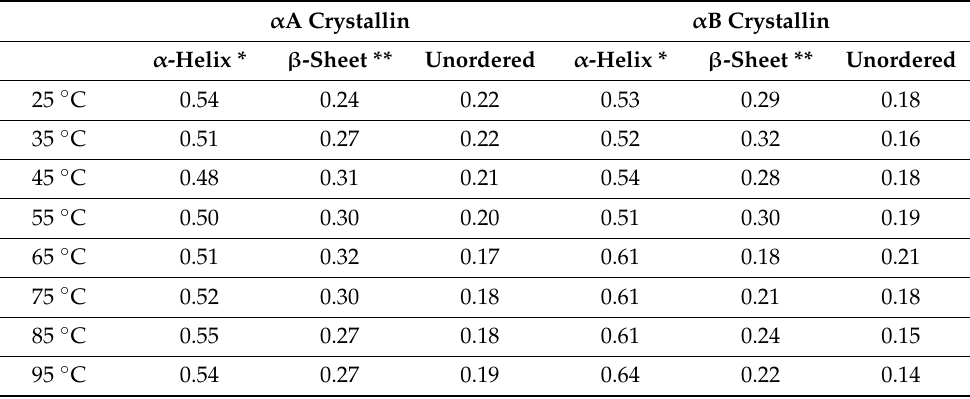
Figure 1. CD spectra of ( A ) α A and ( B ) α B crystallin from 2 ◦ C to 95 ◦ C in 20 mM phosphate buffer (pH 7.4, 2 mM NaCl). Table 1. Secondary structure contents of α -crystallins as a function of temperature extracted from CD spectra in Figure 1.